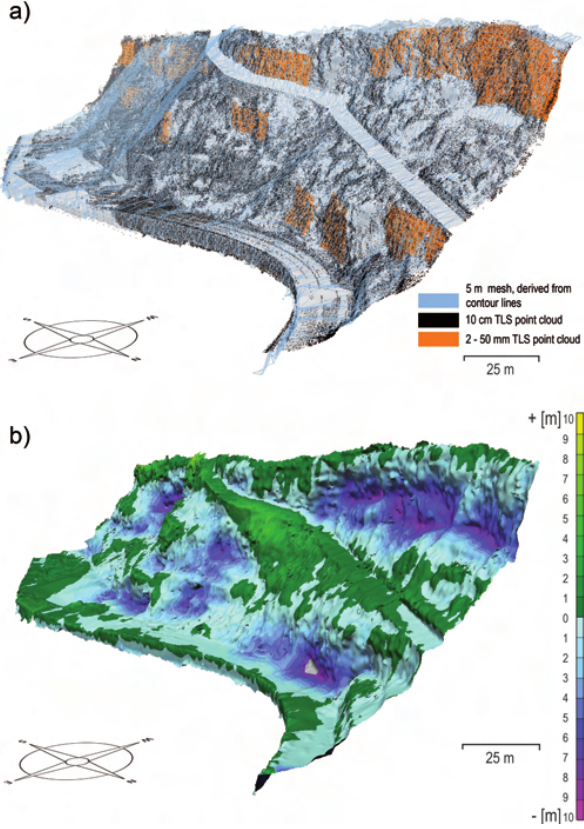
Fig. 4. A 5-m resolution DEM (blue mesh) derived from contour Fig. 4. A 5 m resolution DEM (blue mesh) derived from contour lines of the study area lacks geometrical detail, such as overhangs lines of the study area lacks of geometrical detail such as overhangs or notches. Positioning a 10-cm resolution point cloud (black) or notches. Positioning a 10 cm resolution point cloud (black) into into the data sets improves the vertical geometry in particular. the data sets improves especially the vertical geometry. Simulta- Simultaneously, the DEM can be used to close gaps or to cover neously the DEM can be used to close gaps or to cover less in- less interesting area between different point clouds. For structural terest area between different point clouds. For structural analysis, analysis, the same procedure has been used with high resolution the same procedure has been used with high resolution point clouds point clouds (orange) (a) . The fusion of the different data sets (orange) (a). The fusion of the different data sets results in a high results in a high quality model which differs up to 10m in quality model which differs up to 10 m in comparison to the 5 m comparison to the 5-m resolution DEM (b) resolution DEM (b).